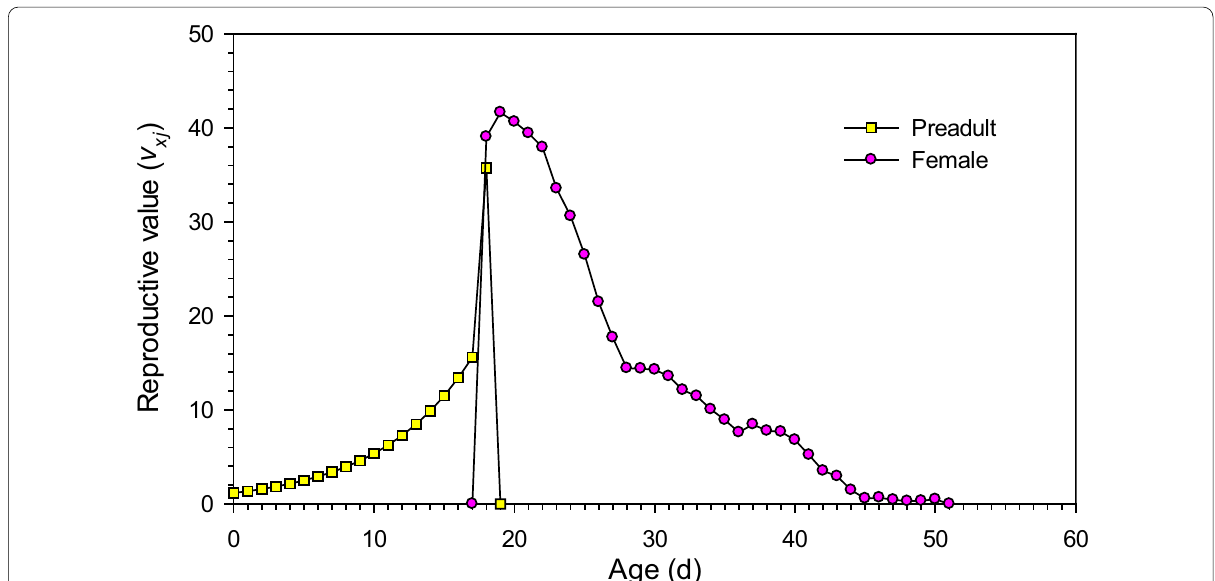
Fig. 4 Age-stage-specific reproductive value ( v xj ) of Leptomastix dactylopii on Planococcus